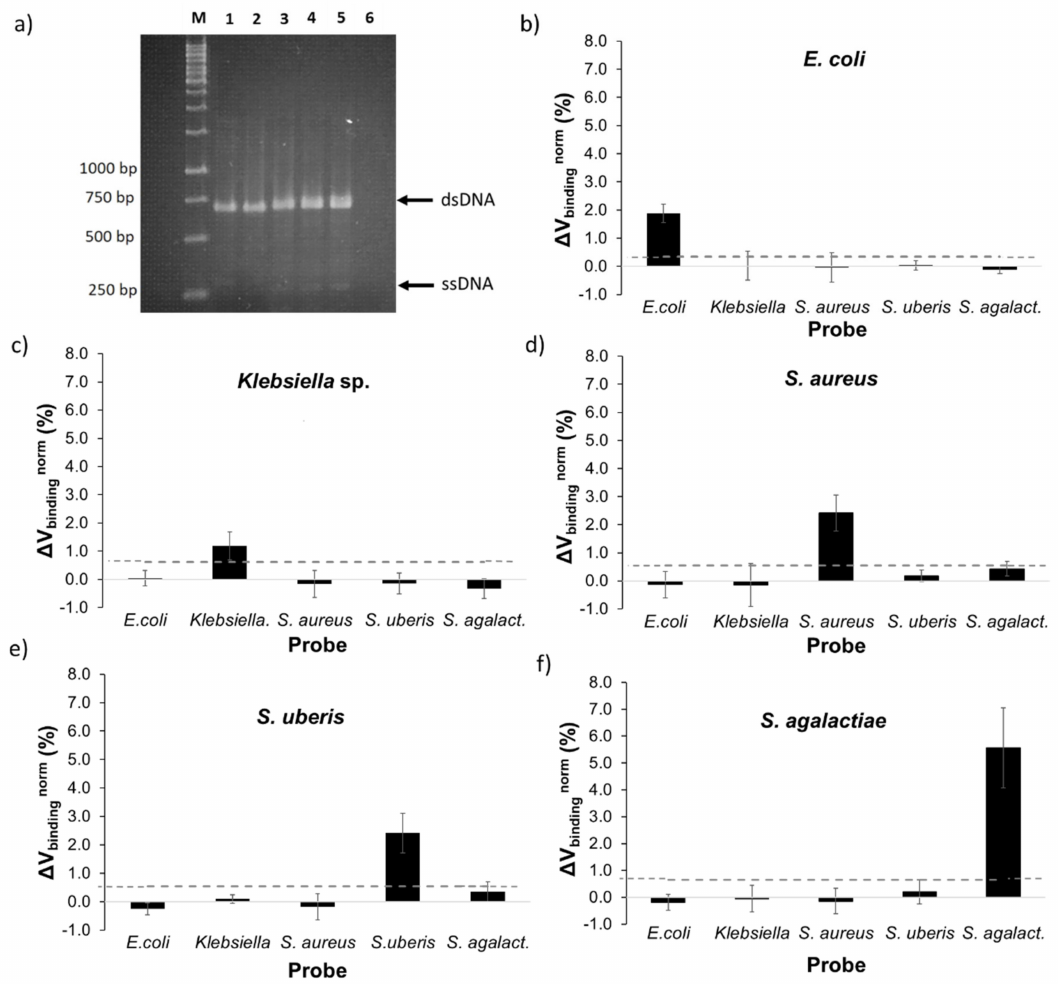
Figure 3. ( a ) Agarose gel electrophoresis of asymmetric polymerase chain reaction (PCR) products obtained from 1 ng / µ L of template DNA in the reaction mixture for five mastitic bacterial